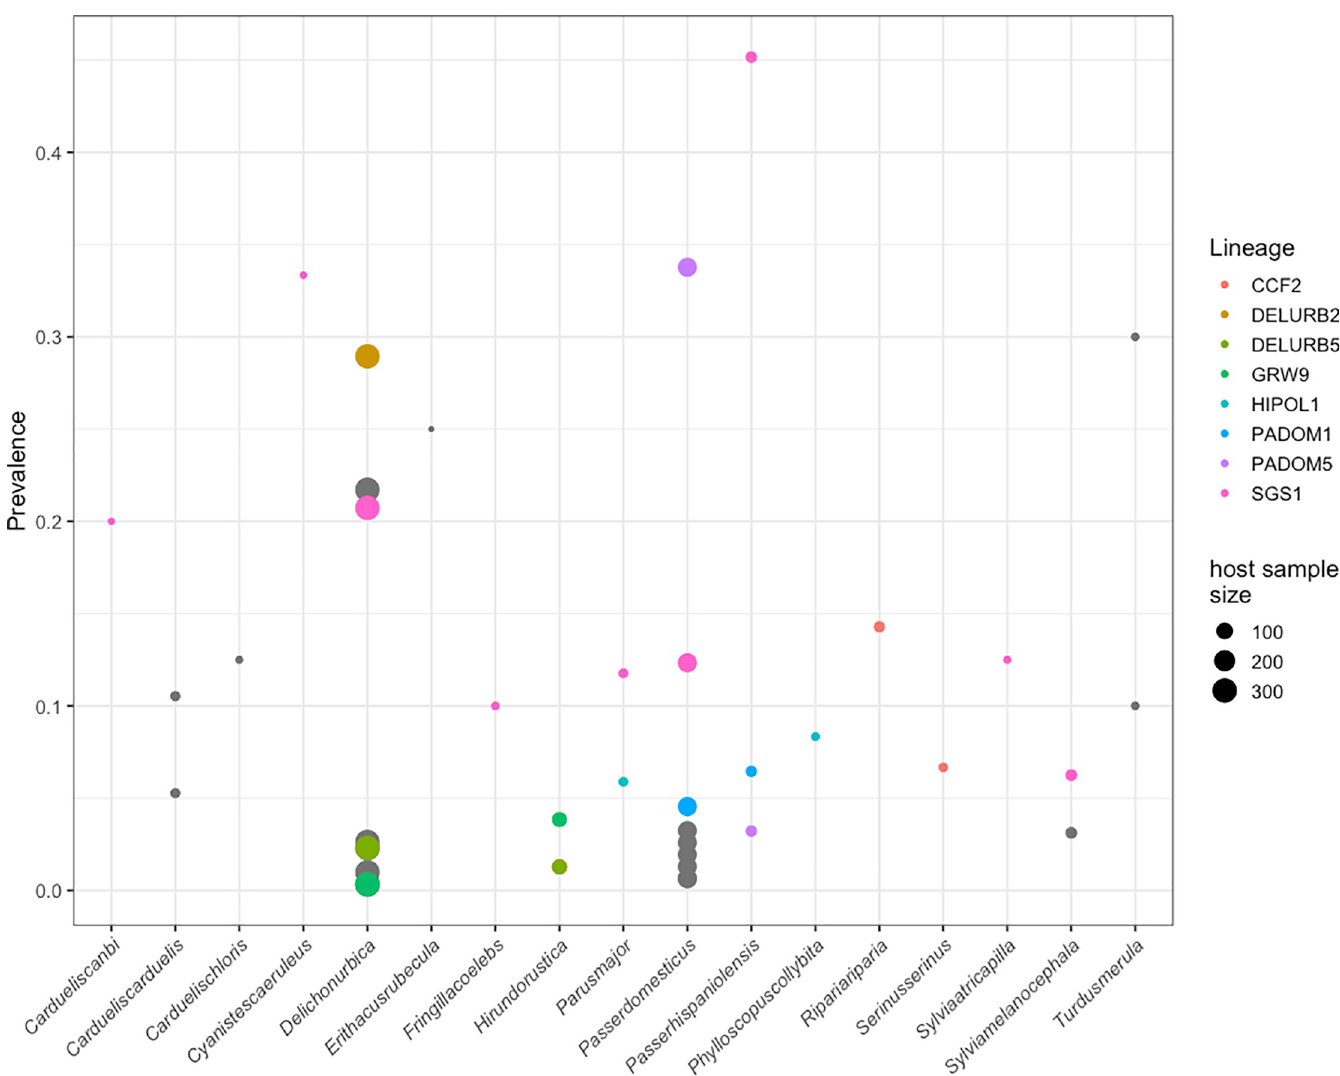
Fig 2. Prevalence of each parasite lineage in every host species found in the community. Bird species with no infection are not present in the figure. Lineages infecting more than one bird species have been colored marked while parasite lineages infected only one host species remain in grey. Note that depending on the underlying sample size, the size of the dots is proportional to the number of